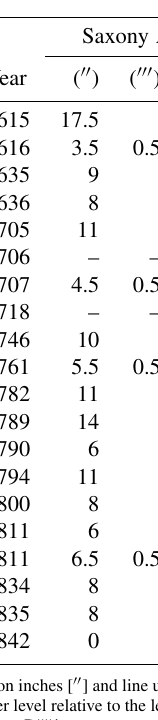
Table 9. An overview of the Saxon DM-type sources (edition of the new series from 1843, Statistik der Gewerbe und Handel, pp.